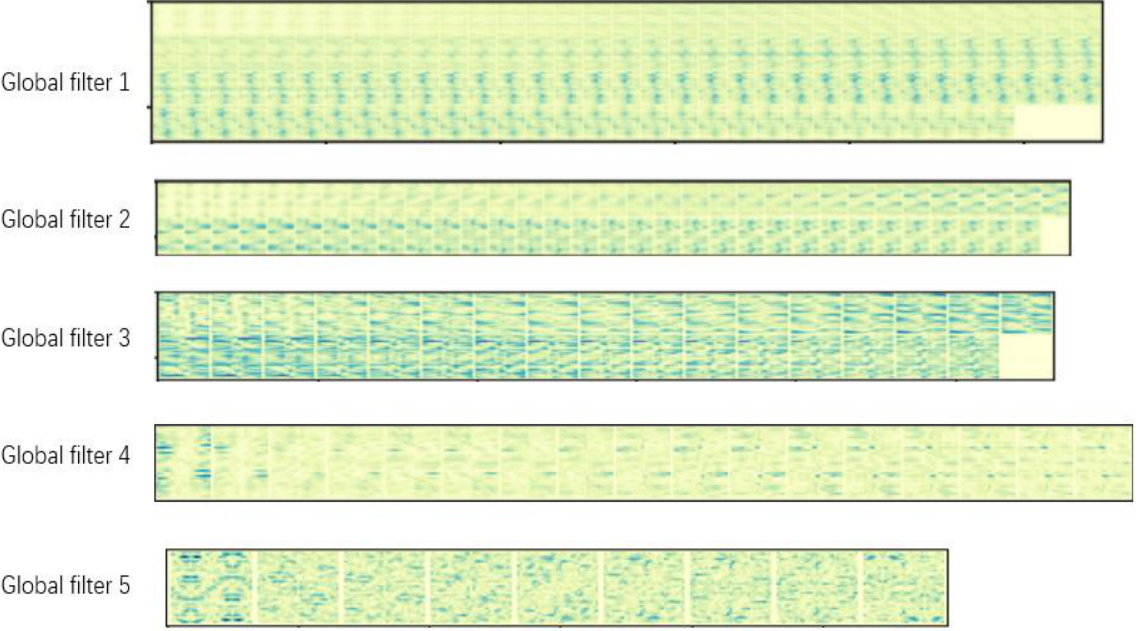
Figure 5. Global filter. The * in the figure represents an element-wise multiplication between frequency-domain features and learnable global filters.